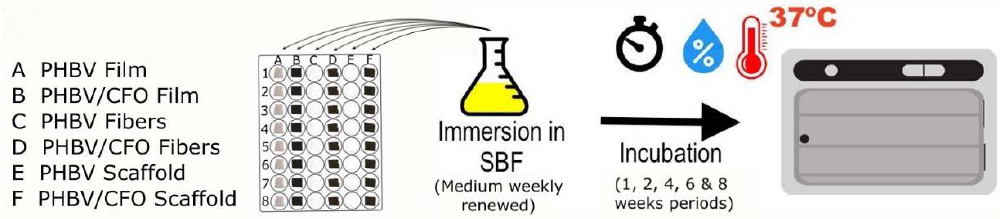
Figure 1. Schematic representation of the steps involved in the degradation assays.